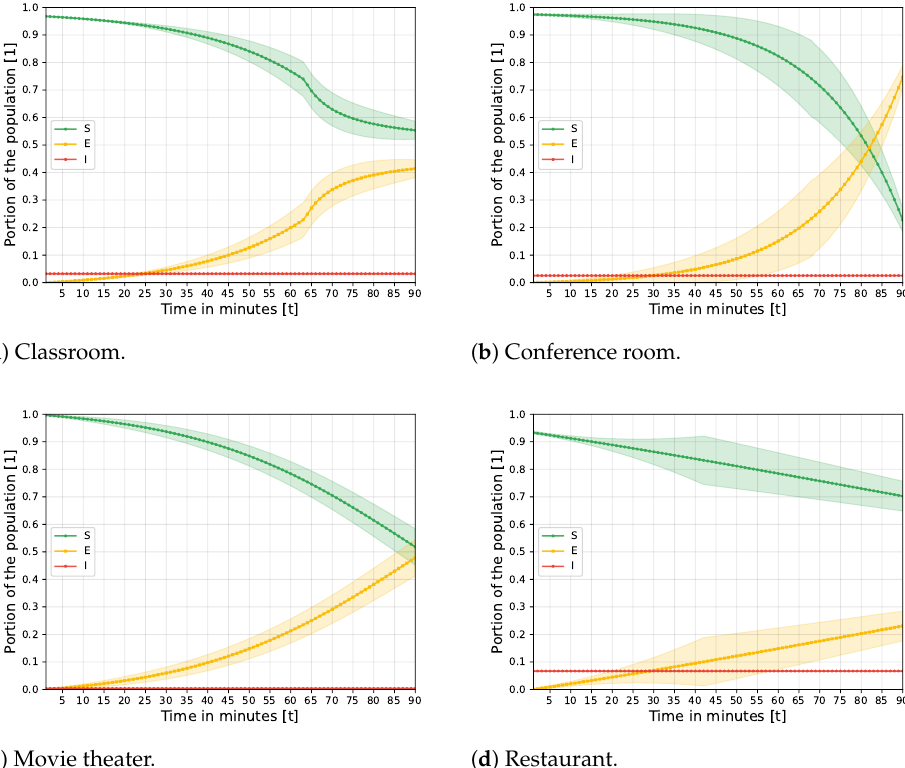
Figure 4. The SEI over time for each type of room, shown as mean ± standard deviation. The results are computed as a result of 100 realisations for each room and 5 rooms for each room type ( n =